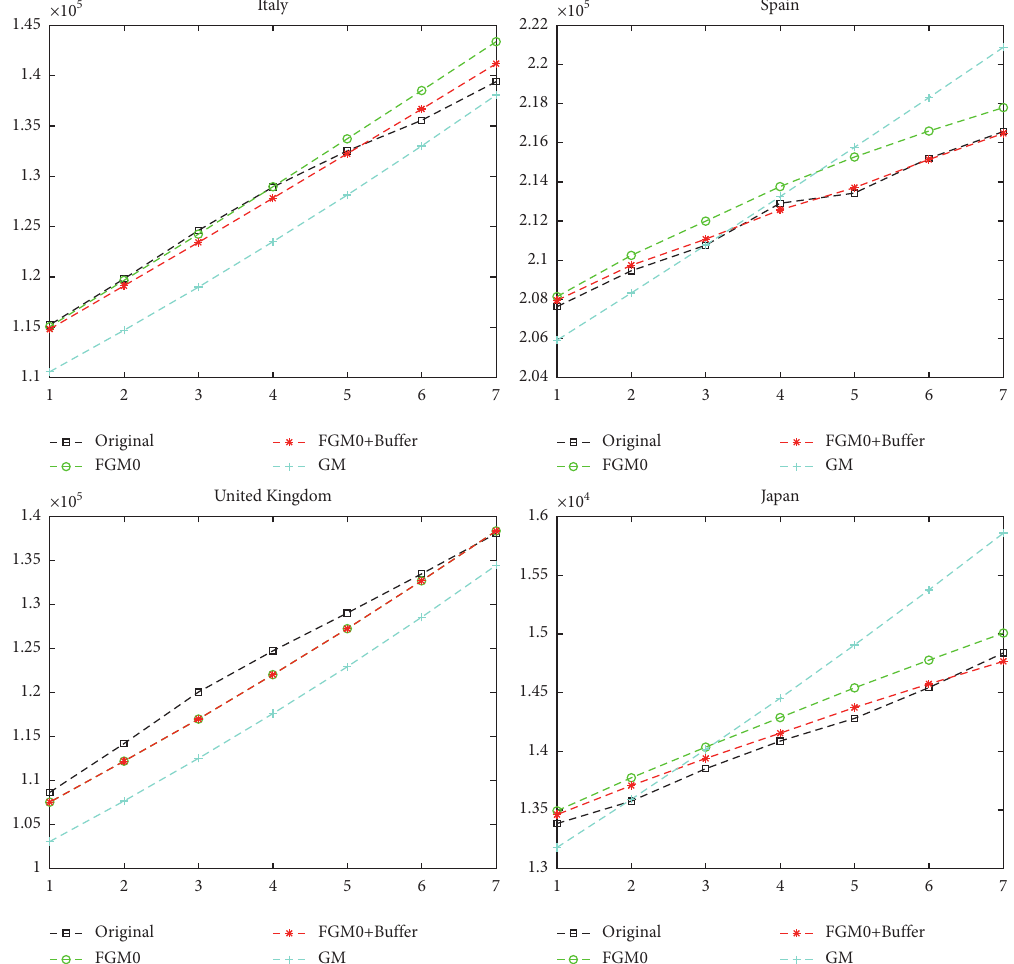
Figure 8: The prediction performance after the government’s control measures took effect (part